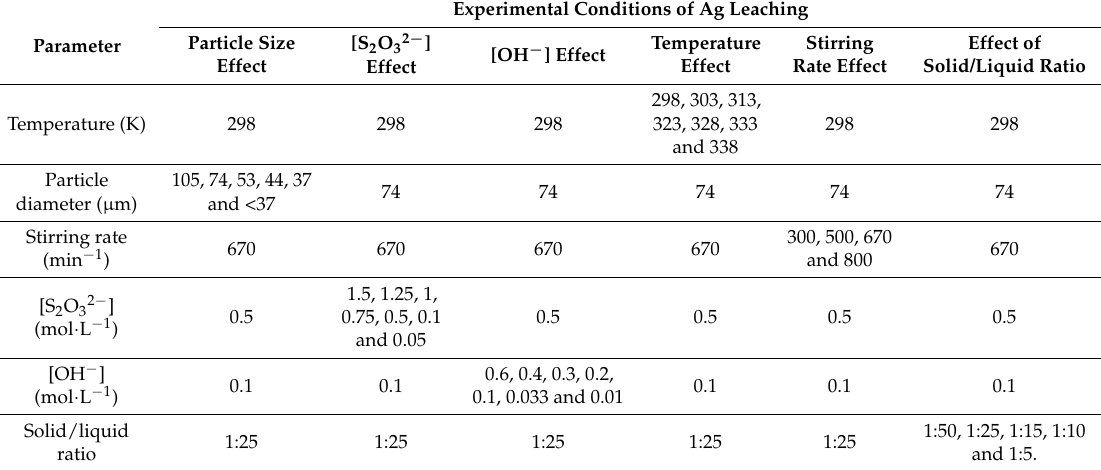
Table 1. Experimental conditions for the evaluated effects in the Ag leaching in the S 2 O 32 − -O 2